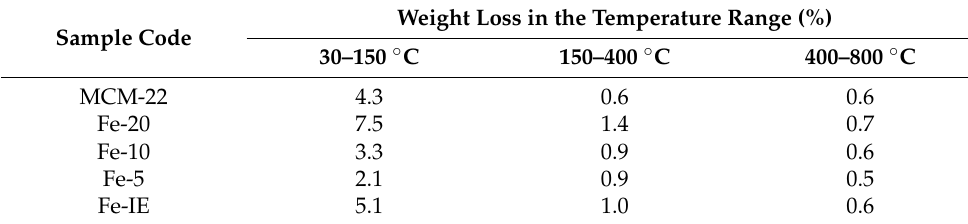
Figure 9. TGA results obtained for the samples. Table 4. Weight loss of the samples determined by TGA experiments.